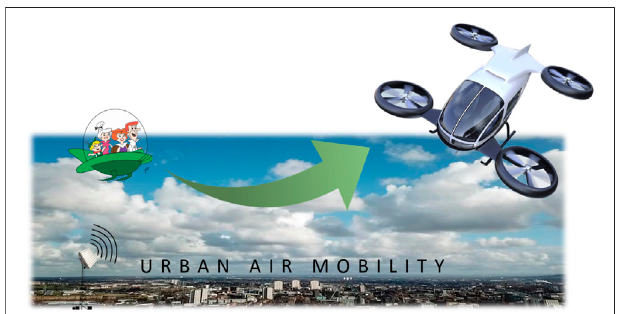
FIGURE 1 | A snapshot of Urban Air Mobility and Airborne Wireless Networks. Proposing 6G to enable Jetsons like Flying Cars in dense urban